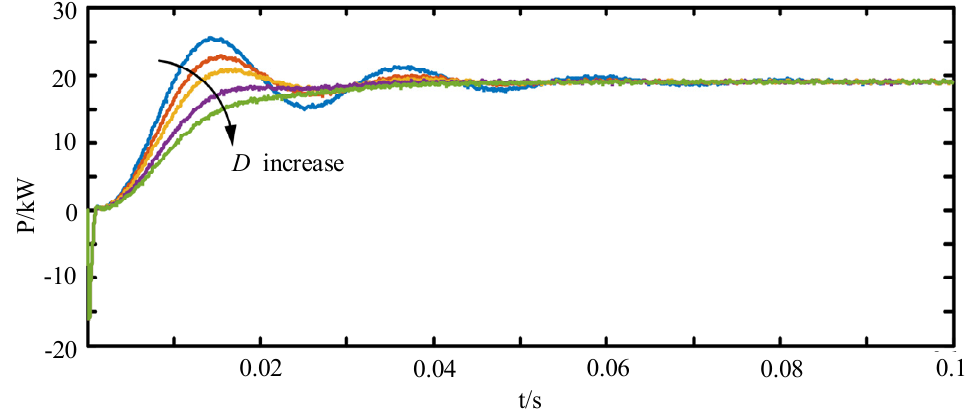
Figure 12. Simulation of damping coefficient affecting system’s active output performance.